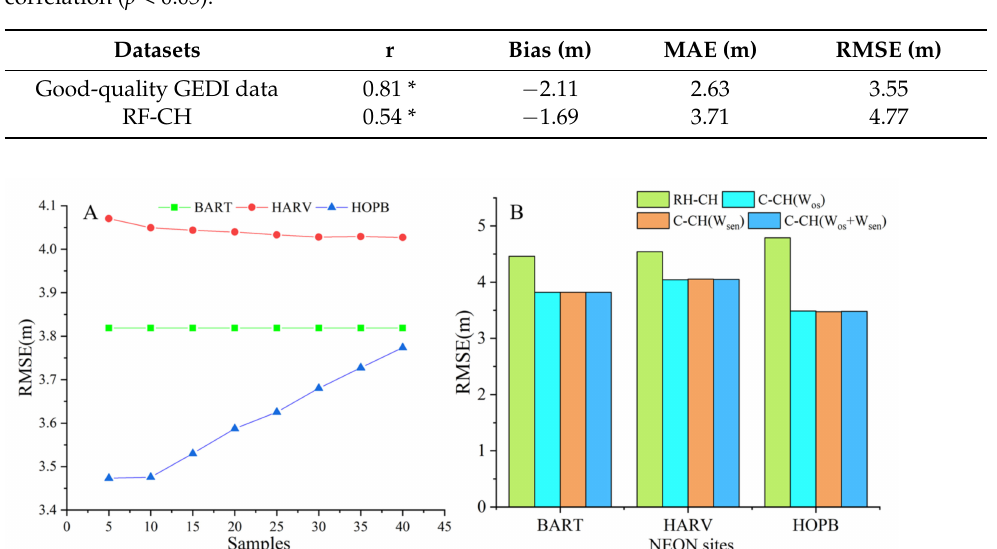
Figure 9. Densities of GEDI observations over space ( A1 , A2 ) and amounts ( B1 , B2 ) within a 6 km width window for each object pixel in RF-CH in Area 1 and Area 2, respectively. Masked areas in ( A1 , A2 ) are displayed in white. Table 6. Accuracy comparison of canopy heights between good-quality GEDI data and RF-CH, compared with NEON RH95. r is the Pearson r correlation, while the asterisk represents a significant correlation ( p < 0.05).